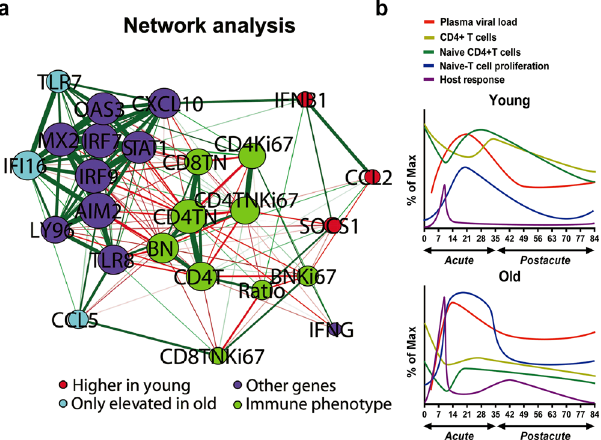
Figure 7. Systematic analysis of data of immunosenescence, disease progression and host response. ( a ) The correlation network of immunophenotype and gene expression data was constructed by using the qgraph package with R. The 4 groups of nodes are colored on the basis of data types. The groups include genes expressed higher in the young group ( IFNB1 , CCL2 and SOCS1 ), genes elevated in only the old group ( TLR7 , IFI16 and CCL5 ), other genes significantly correlated with immunophenotype ( OAS3 , CXCL10 , MX2 , IRF7 , STAT1 , IRF9 , AIM2 , LY96 , TLR8 and IFNG ) and an immunophenotype that differed between the young and old groups (CD4T, CD4 + T cell number; Ratio, CD4/CD8; CD4TN, naïve CD4 + T cell number; CD8 TN, naïve CD8 + T cell number; CD4Ki67, % of Ki67 + CD4 + T cells; CD4TNKi67, % of Ki67 + CD4 + T cells; CD8TNKi67, % of Ki67 + CD8 + T cells; BN, naïve B cell number; BNKi67, % of Ki67 + naïve B cells). The node size indicates the relative strength value according to a centrality analysis. The thicker lines indicate more correlated genes. The green lines represent significantly positive Pearson correlation coefficients ≥ 0.40, and the red lines represent significantly negative Pearson correlation coefficients ≤ − 0.40. ( b ) Model of immunosenescence, disease progression and host response in ChRM that demonstrates their variation differences during early SIV infection as detailed in the text. Immunosenescence is shown by the numbers of naïve CD4 + T cells and the percentage of Ki67 + naïve T cells. The plasma viral loads and CD4 + T cell numbers represent the level of disease progression. The innate host response is defined by the fold-changes of differentially expressed genes. The smooth curves were constructed by a spline fit method using GraphPad Prism 6